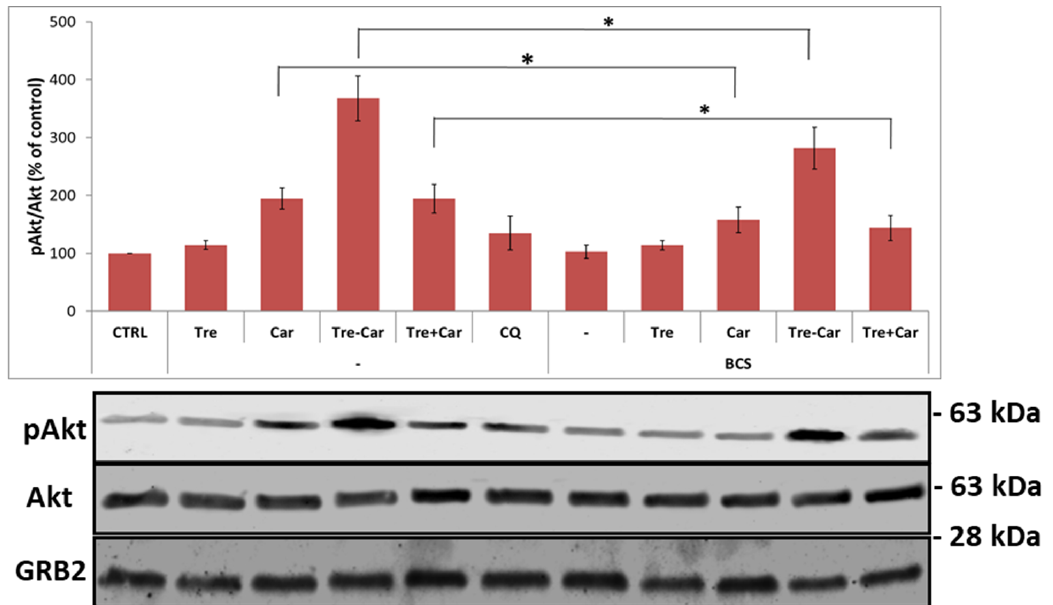
Figure 7. Akt phosphorylation is increased by Car and Tre-Car. Representative western blotting and densitometric analyses of pAkt in PC12 cells treated with 5 mM of studied compounds or 10 µM CQ for 15 min in RPMI-1640 complete medium without FBS or in the presence of 50 µM BCS, 24 h pretreated medium. The phosphorylated level of Akt was reported as ratio over the total Akt protein (* p ≤ 0.05 versus the respective control/treatment). Dashes to the right of the membrane bands show positions of prestained molecular mass marker.